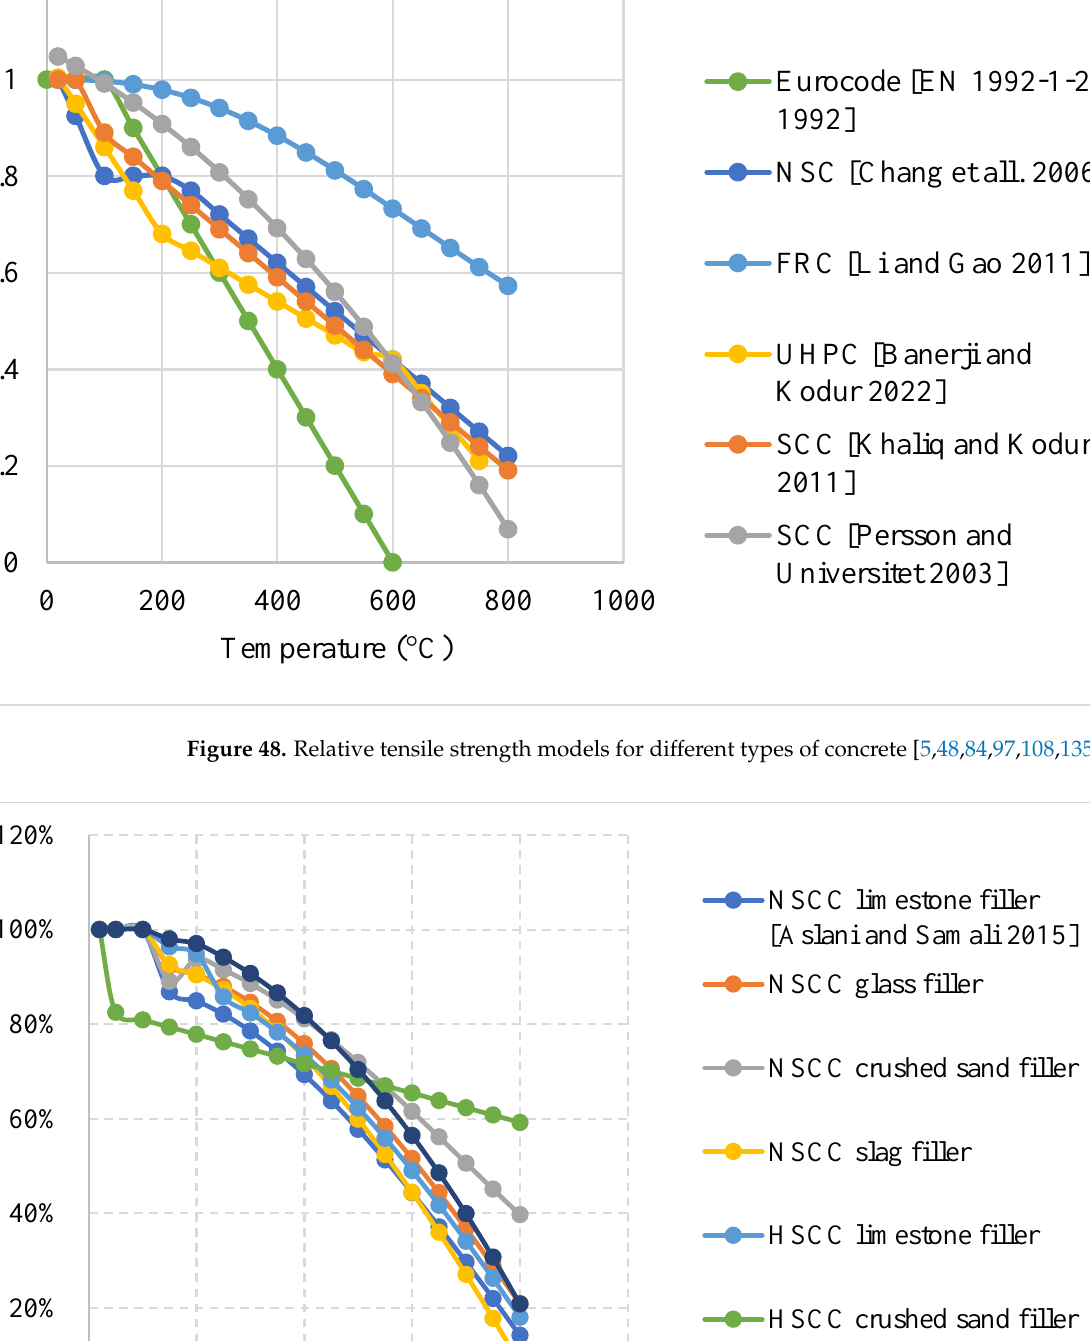
Figure 47. Relative compressive strength models for different types of concrete [48,75,97,108,135].